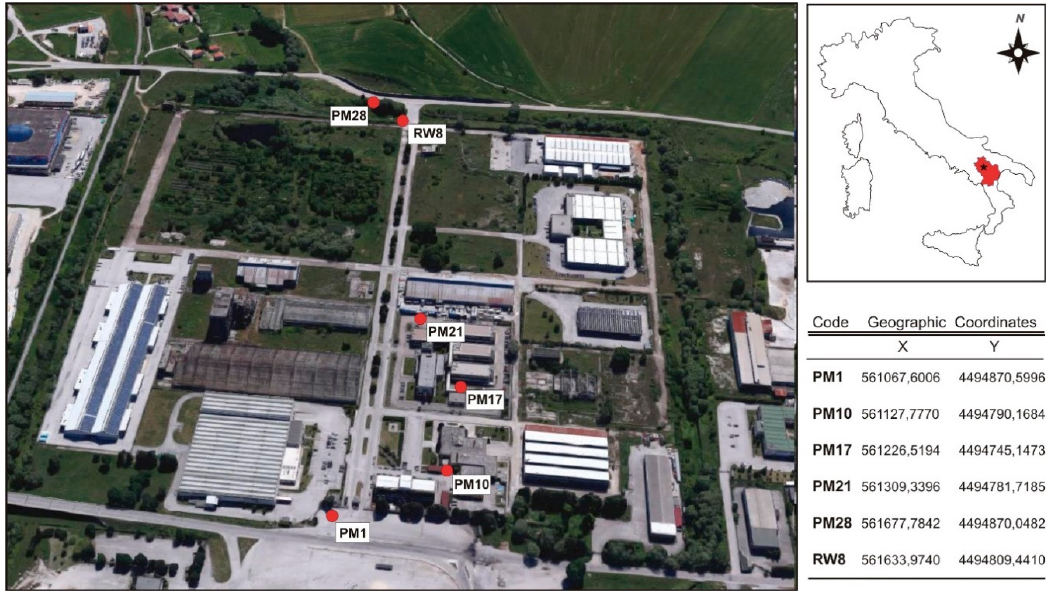
Figure 1. View of the study area with the sampling points and geographic coordinates.